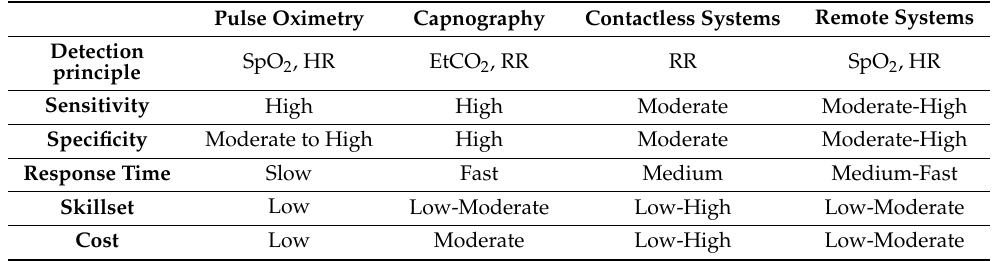
Table 2. Summary of devices used in the detection and diagnosis of OIRD. (HR = heart rate; RR = respiratory rate; EtCO 2 = end-tidal CO 2 ; SpO 2 = oxygen saturating point). Pulse Oximetry Capnography Contactless Systems Remote Systems Detection SpO 2 , HR EtCO 2 , RR RR SpO 2 , HR principle Sensitivity High High Moderate Moderate-High Specificity Moderate to High High Moderate Moderate-High Response Time Slow Fast Medium Medium-Fast Skillset Low Low-Moderate Low-High Low-Moderate Cost Low Moderate Low-High